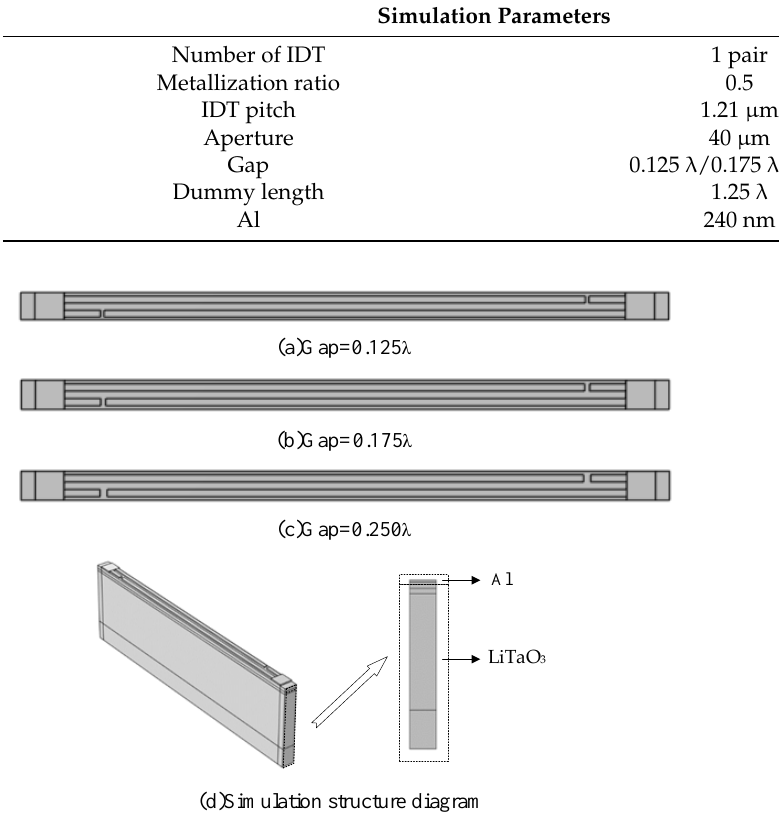
Figure 2. Diagram based on the simulation parameters in Table 1. ( a ) gap = 0.125 λ; ( b ) gap = 0.175 λ; ( c ) gap = 0.25 λ; ( d ) simulation structure diagram.